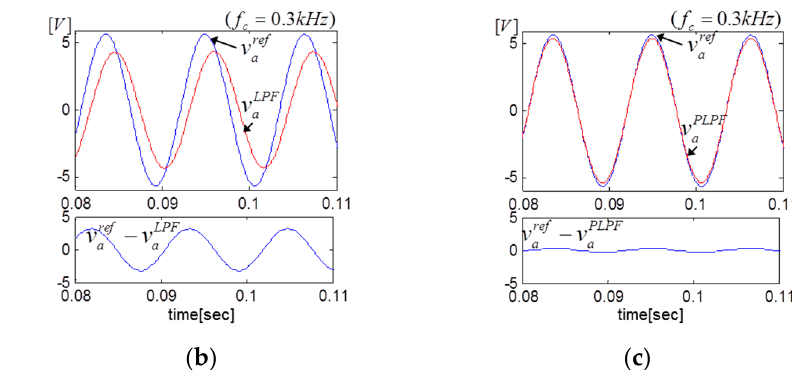
Figure 13. Difference between reference and measured voltage according to filter: ( a ) low-pass filter